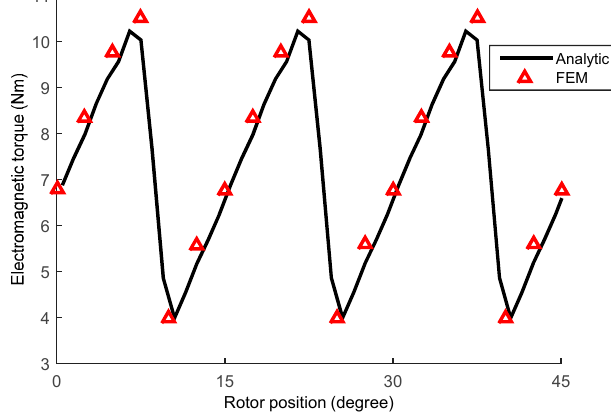
Figure 10. Electromagnetic torque vs. rotor position.